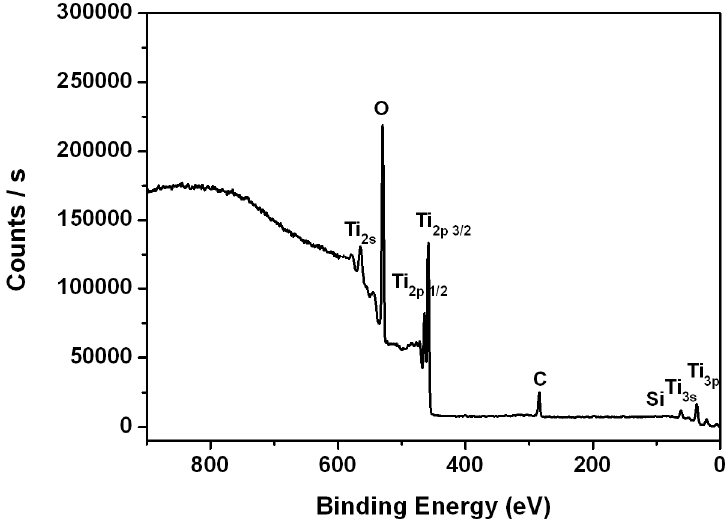
Figure 4. X-ray photoelectron spectroscopy (XPS) picture of optical fiber deposited with TiO 2 nanofilm.